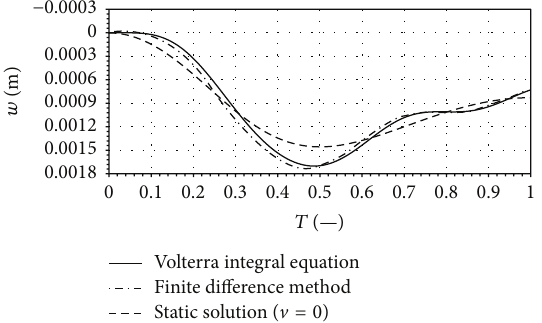
Figure 13: Dynamic deflection of point “a” (middle of the first span) due to a moving distributed load.